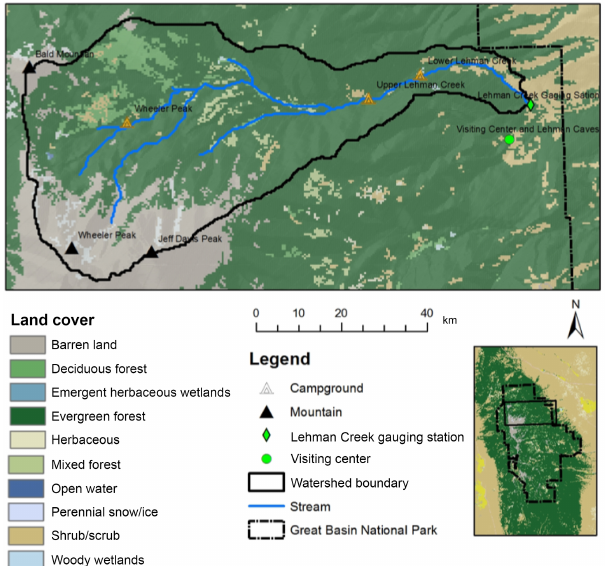
Figure 10. PRMS hydrologic model study area, which was derived from the vegetation map obtained from the National Land Cover Database (NLCD, 2011) with 30m resolution. The map is drawn based on data from Yang et al. (2018).